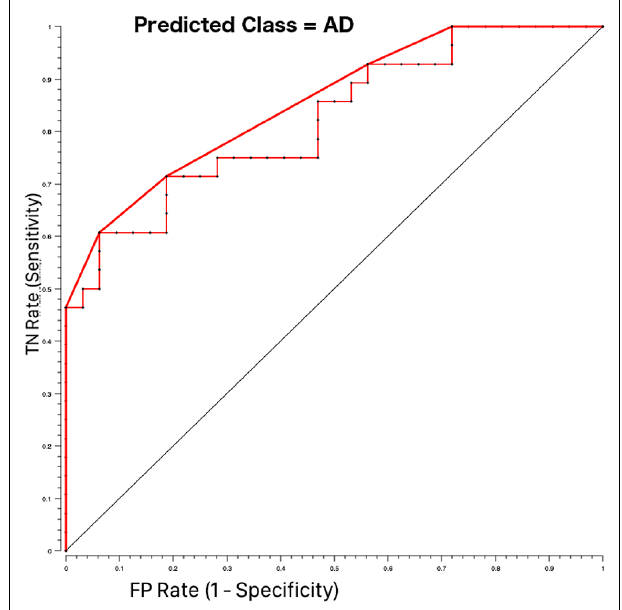
FIGURE 4 | Receiving operating characteristics (ROC) curves for AD-HOC classification using Random Forest feature selection. The pathological class (AD = 1) was considered as the target class. The curve shows higher performance (bold red line) than the majority algorithm (diagonal). TN rate is the rate of true negatives and the FP rate is the rate of false